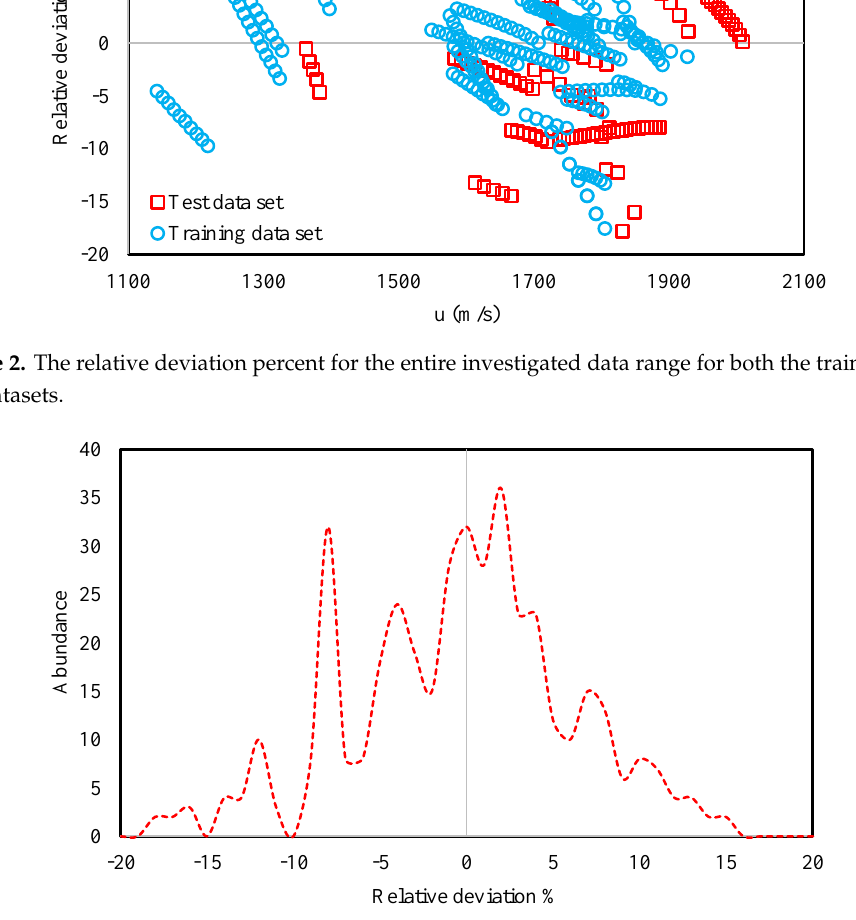
Figure 3. The distribution behavior of the relative deviation percent of the proposed model for the overall dataset.